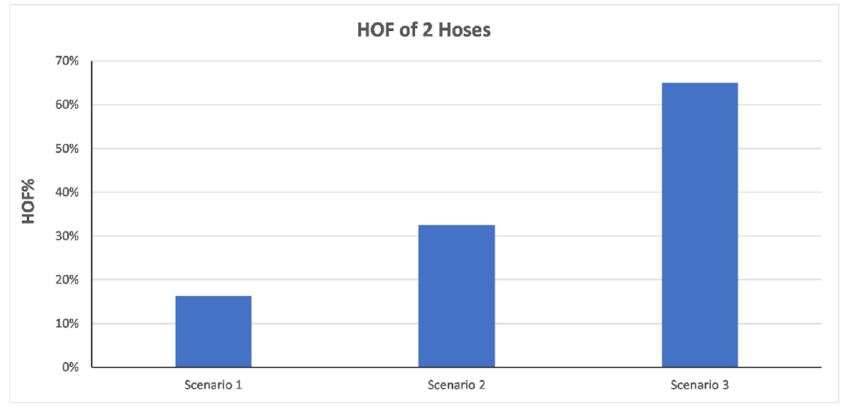
Figure 7. HOF indicator for 1 dispenser.